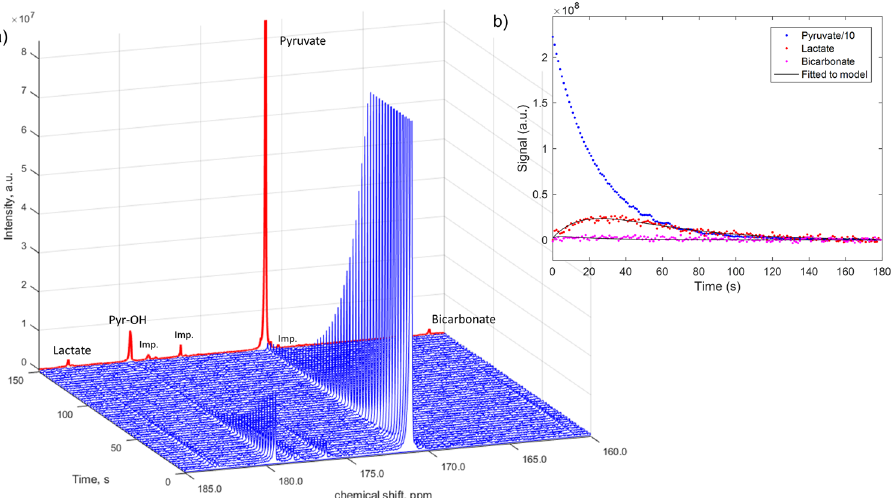
Figure 3. ( a ) Plot of stacked spectra (blue) acquired every 1 s over 180 s. Every 3 rd spectrum from 1–150 s shown for clarity. The sum of all spectra in the time course (normalized to the maximum intensity of the time course spectra) is shown in red. Other peaks observed in the hyperpolarized spectrum were: (i) pyruvate-hydrate (Pyr-OH), a commonly observed, non-metabolically active, molecule that is in fast chemical exchange with pyruvate; and (ii) other unknown impurities present in the supplied 13 C 1 -pyruvic acid. The impurities were confirmed by their presence in the spectra of a control hyperpolarization experiment conducted in the absence of sperm (data not shown). Peaks at the chemical shifts observed for lactate and bicarbonate were not observed in the control experiment. ( b ) Lactate, bicarbonate and pyruvate integrals versus time for washed sperm. Pyruvate integrals were divided by a factor of 10 to scale them to the same order of magnitude as the lactate